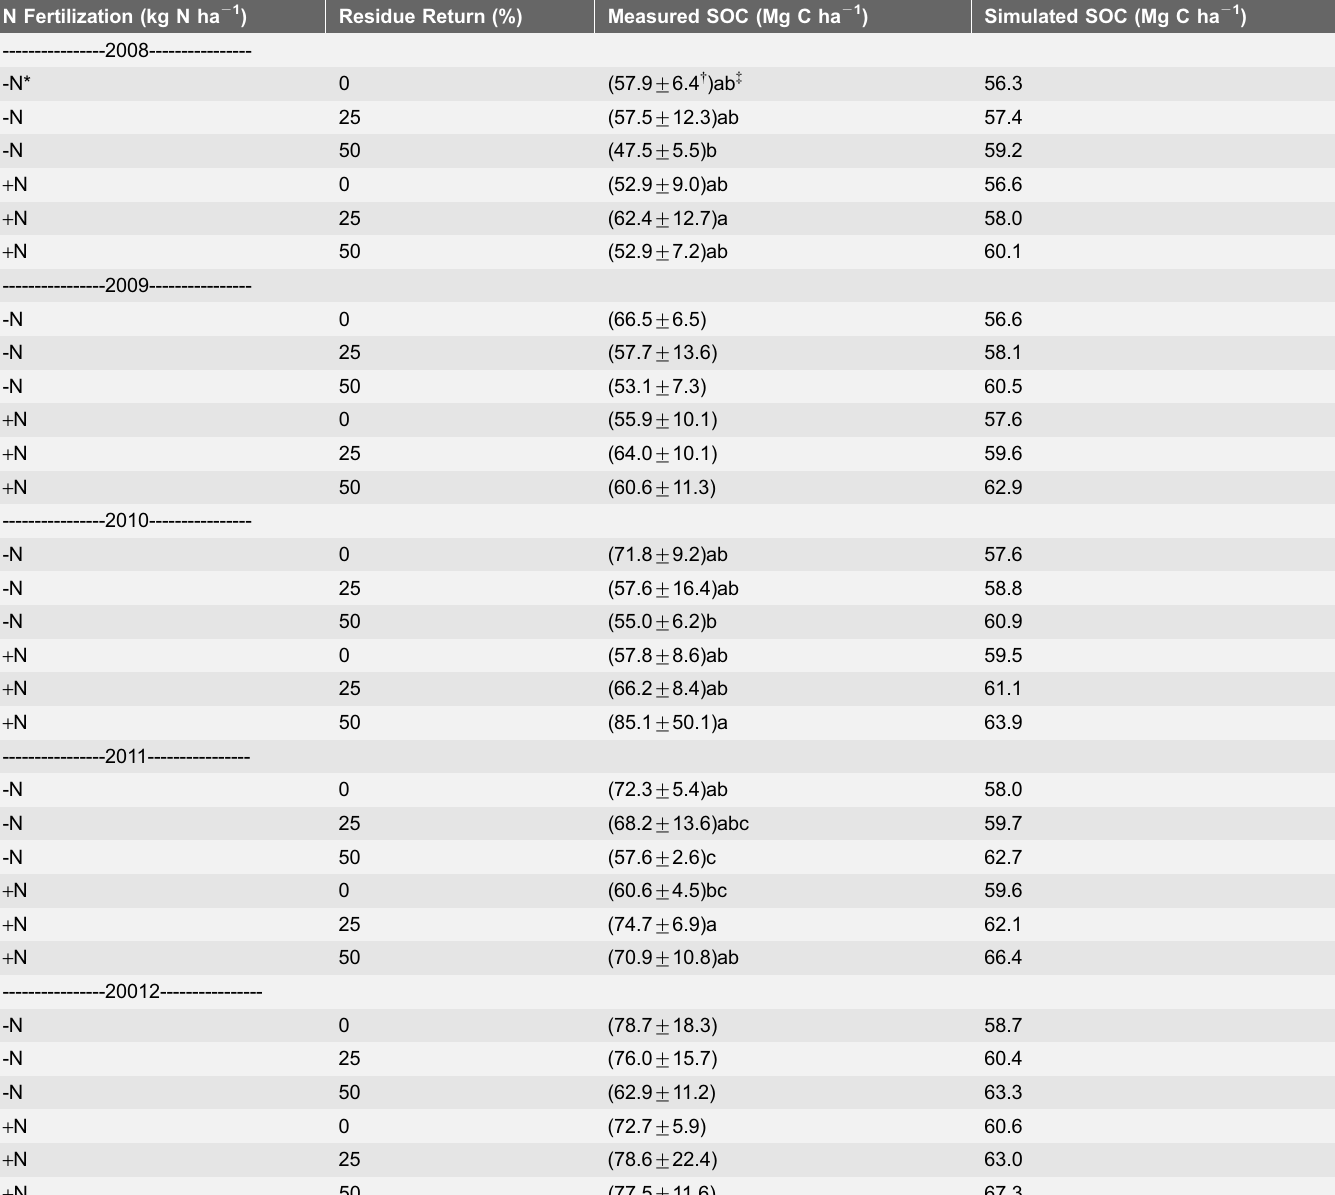
Table 6. Measured and simulated soil organic C (Mg C ha 2 1 ) as affected by residue removal and N fertilization under bioenergy sorghum at College Station, Texas. N Fertilization (kg N ha 2 1 )